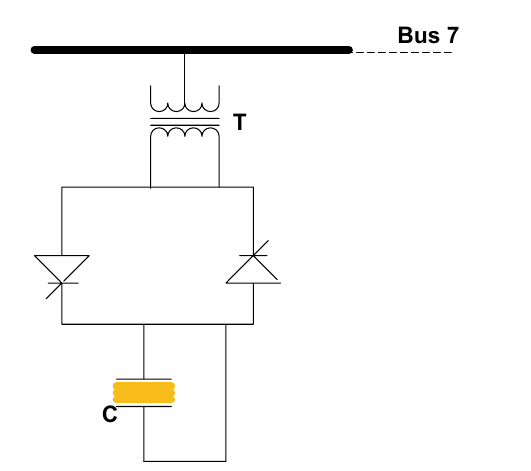
Fig. 16 Structure of STATCOM